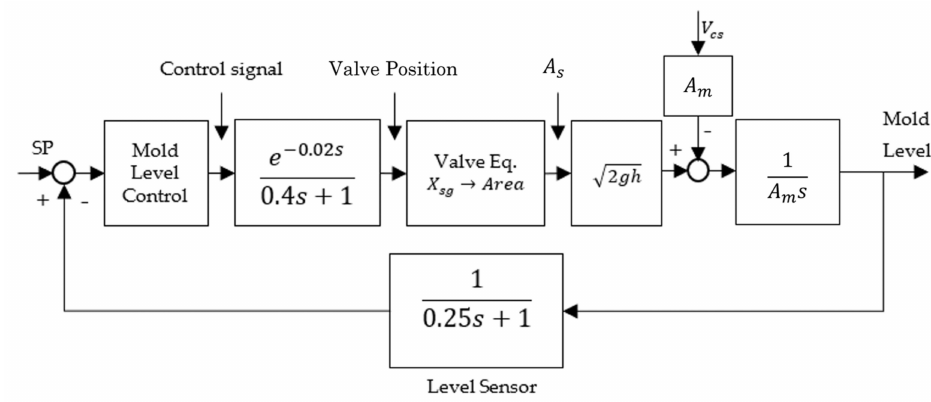
Figure 4. Block diagram of mold level control.